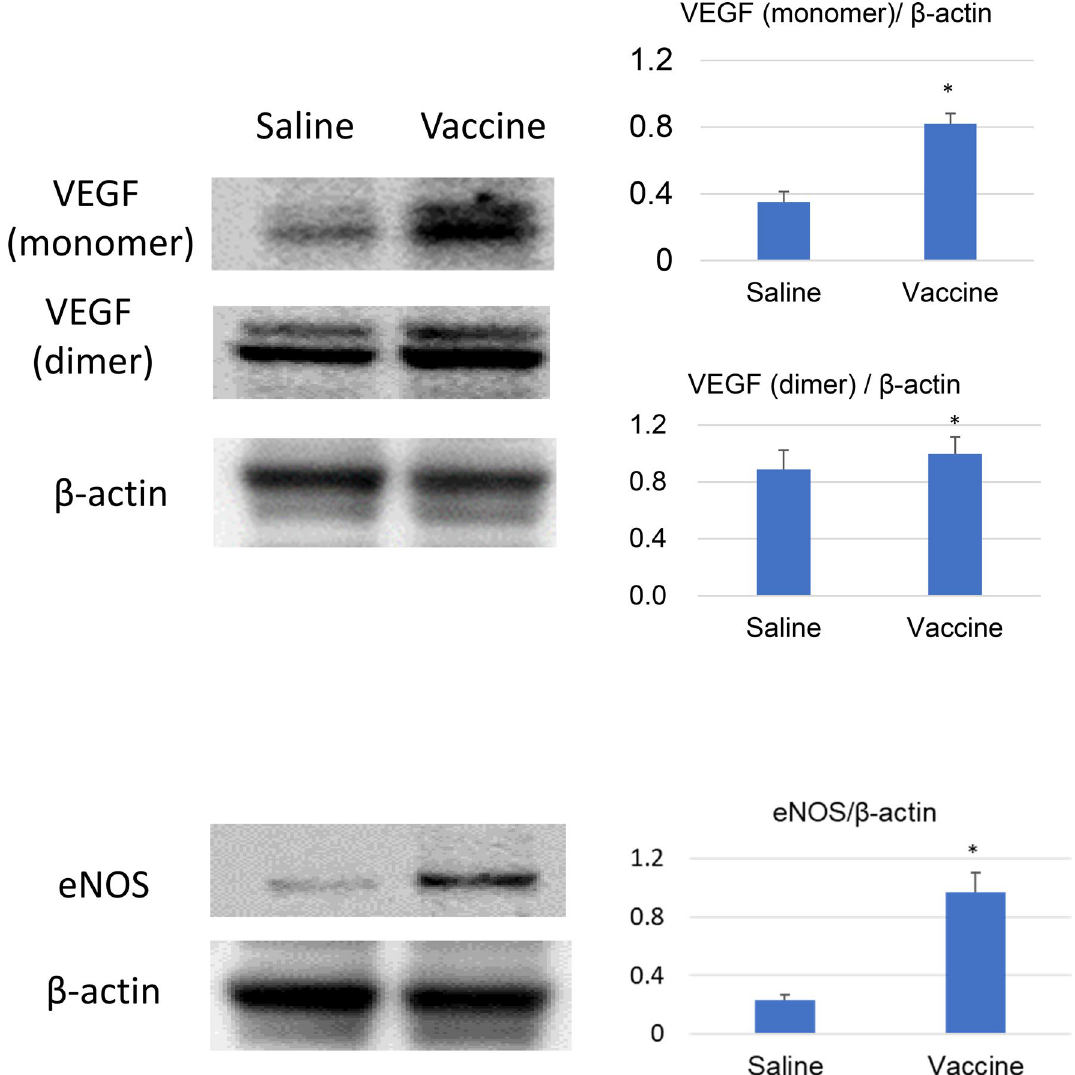
Figure 5. sEH vaccine treatment upregulates VEGF and eNOS. Vascular endothelial growth factor (VEGF) and endothelial nitric oxide synthase (eNOS) in the heart were analyzed by Western blot. β-actin was used as a control. Saline group (n = 4), vaccine group (n = 4). *P <